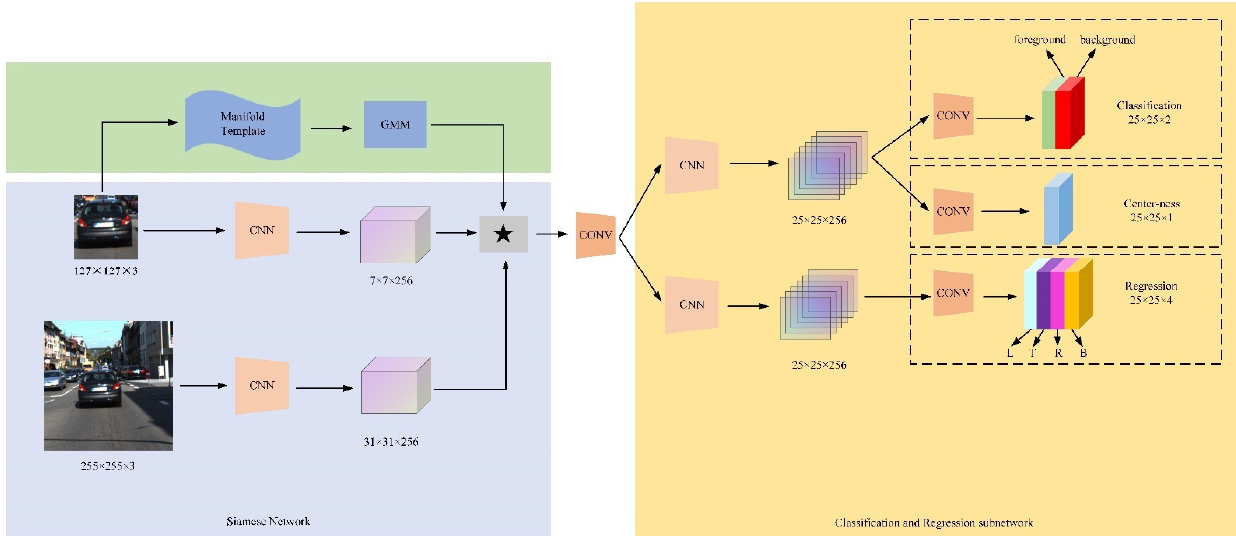
Figure 2. The pipeline of the proposed SiamMFC tracker, where the left side is the semantic feature and geometric feature extraction sub-network, and the right side is the classification and regression sub-network.